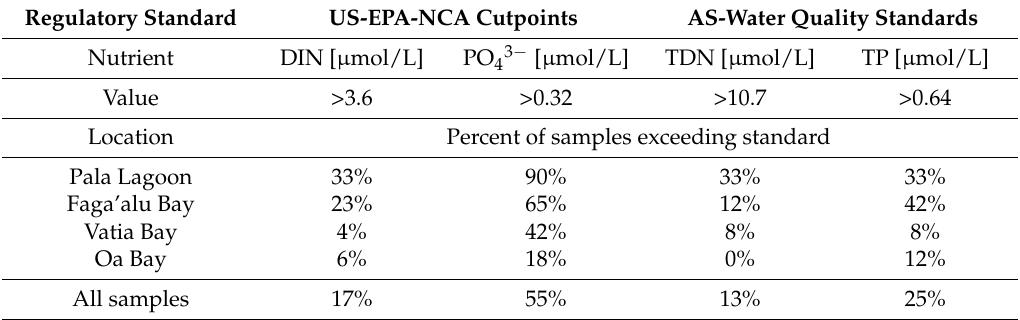
Table 6. American Samoa water quality standards and NCA cutpoints defining “poor” water quality, with percentages of exceedance observed in coastal water samples from the four study locations, and aggregated for all